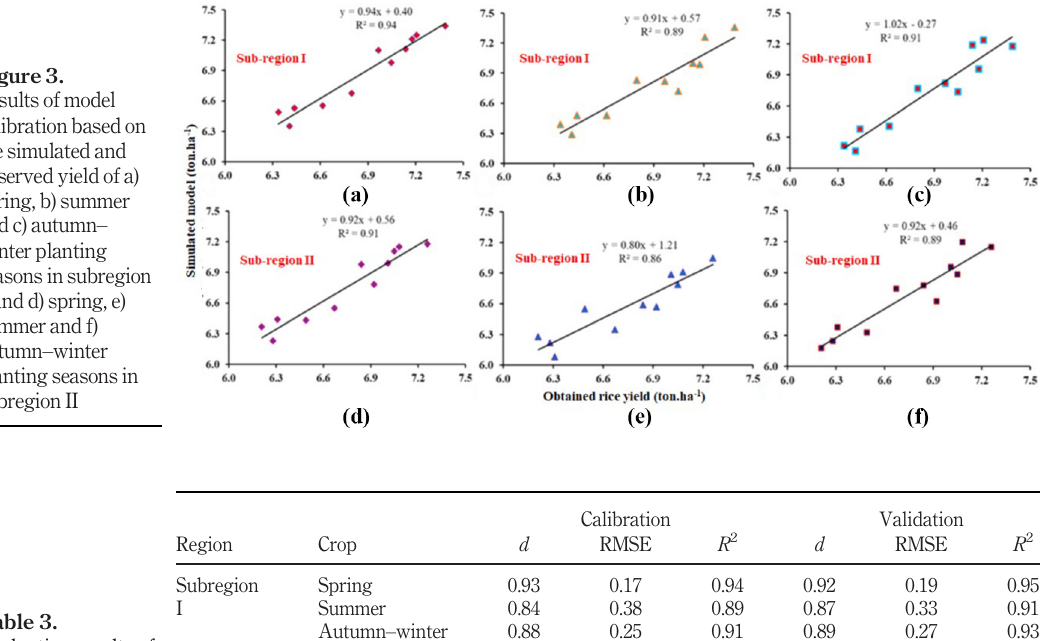
Table 3. Evaluation results of the performance